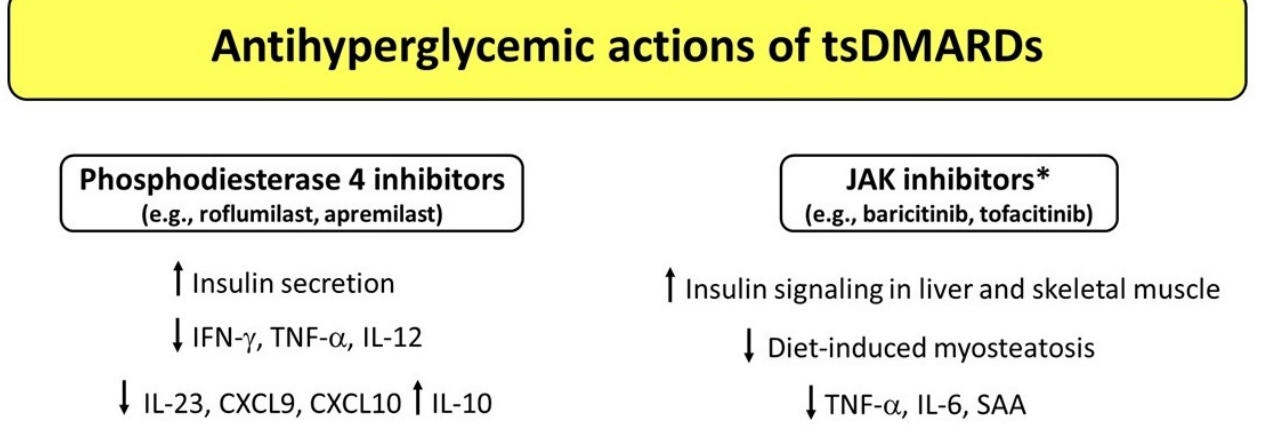
Figure 2. Potential mechanisms underlying the antihyperglycemic actions exerted by targeted synthetic DMARDs (tsDMARDs). * Studies conducted in mice (baricitinib) and rats (tofacitinib). Abbre- viations: CXCL9, C-X-C motif chemokine ligand 9; CXCL10, C-X-C motif chemokine ligand 10; DMARDs, disease-modifying antirheumatic drugs ; IFN- γ , interferon- γ ; IL, interleukin; SAA, serum amyloid A; TNF- α, tumor necrosis factor α.